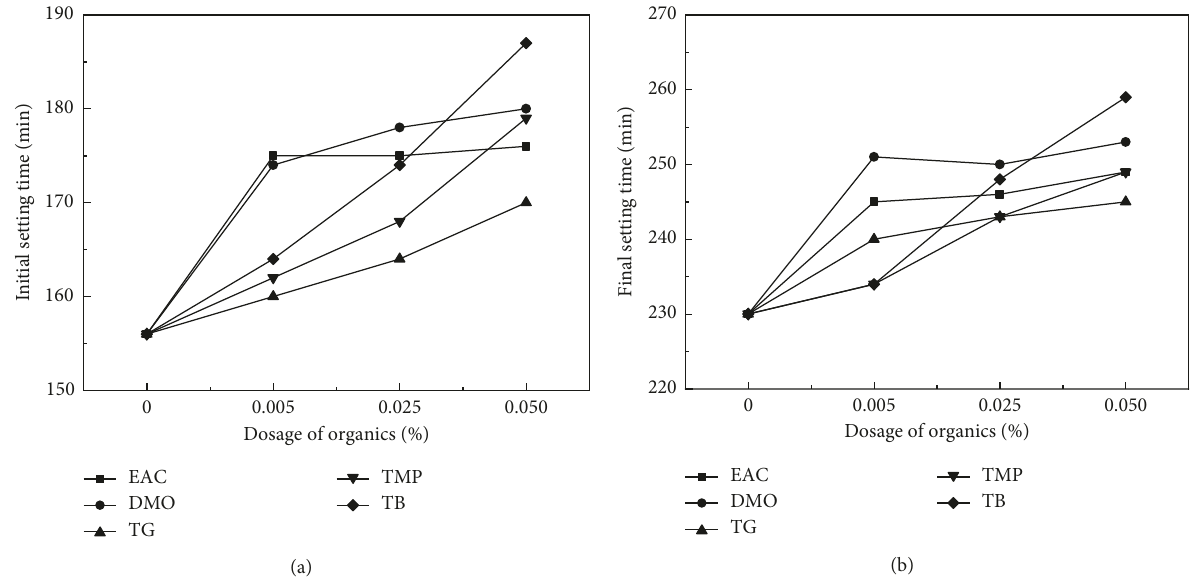
Figure 7: Effect of ester organics on the setting time of cement. (a) Initial setting time. (b) Final setting time.